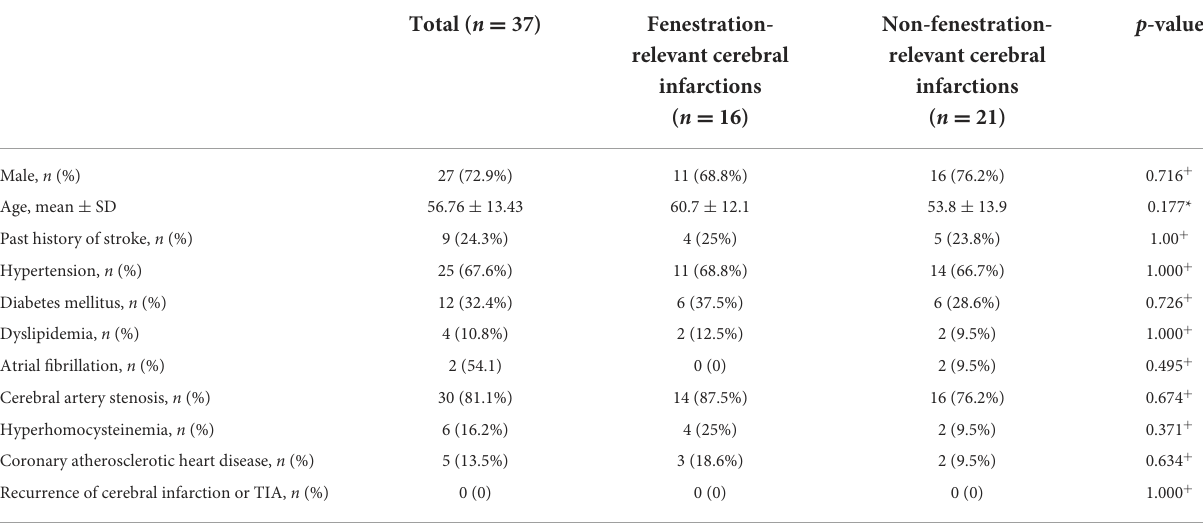
TABLE 4 Differences in risk factors between fenestration-relevant and non-fenestration-relevant cerebral infarctions. Total ( n = 37) Fenestration- relevant cerebral